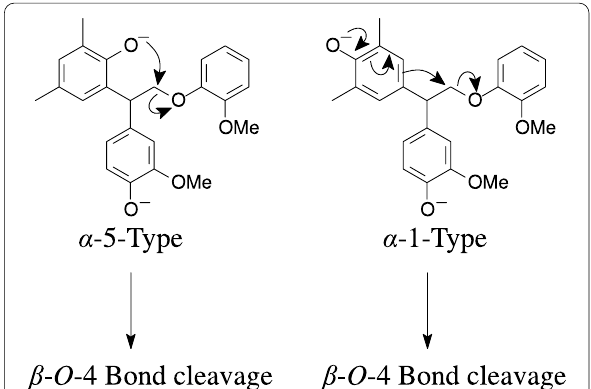
Fig. 2 Progress of the β - O -4 bond cleavage in model compounds of the α -5- and α -1-type condensation substructures [14]